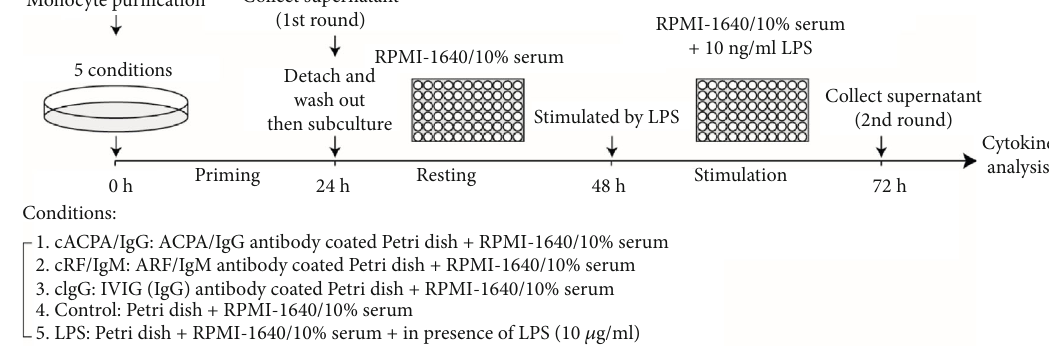
Figure 1: Schematic overview of in vitro trained immunity model by RA autoantibodies. Freshly isolated CD14+ human monocytes were cultured for 24h in RPMI 1640 medium in Petri dishes precoated with 10 μ g/ml puri fi ed ACPA IgG (cACPA/IgG), RF IgM (cRF/IgM), or IVIG (cIgG). Control cells were cultured with RPMI 1640 medium or in the presence of LPS (1 μ g/ml). After priming, the monocytes were detached, washed, and subcultured in 96-well plates for resting. Then, the Mo(cACPA/IgG), Mo(cRF/IgM), Mo(cIgG), Mo(control), and Mo(LPS) were stimulated by LPS (10 ng/ml) for 24 h. Cytokines and chemokines in the supernatants from either the priming or stimulation phase were measured by